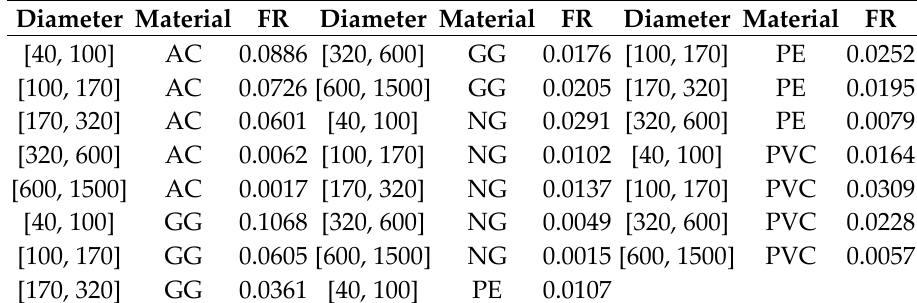
Table 2. Pipe failure rates (FR: number of failures/(km·year)) based on pipe diameter and material (asbestos cement [AC], grey cast iron [GG], nodular cast iron [NG]) [6].